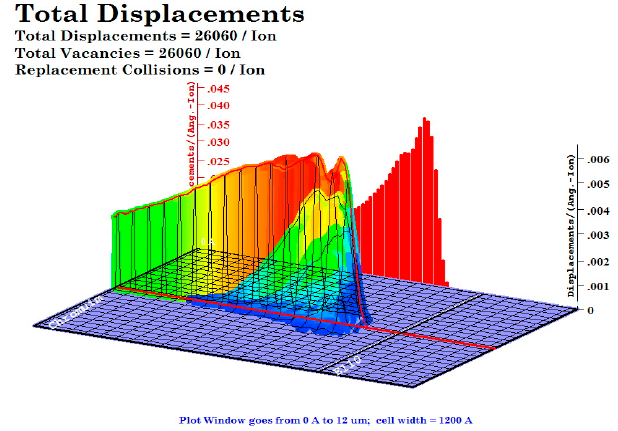
Figure 15. Damage caused by 120 MeV Pd in E110 alloy, coated with 9 µm thin film of Cr.